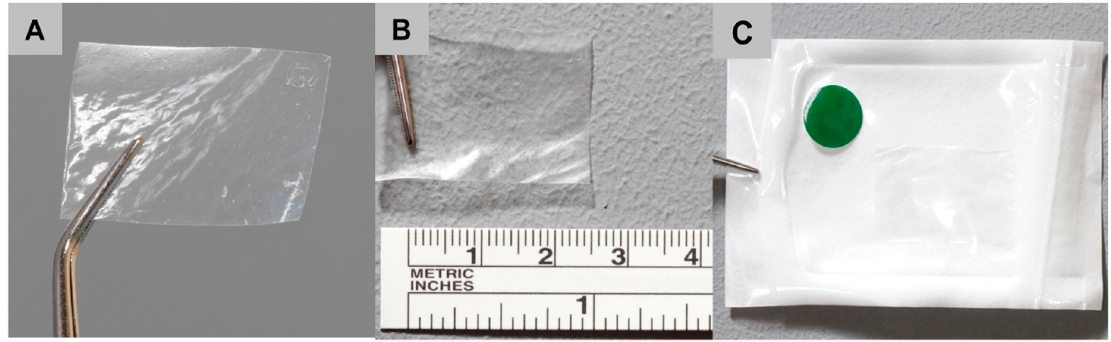
Figure 5. Image of the newly developed transparent collagen membrane ( A – C ).